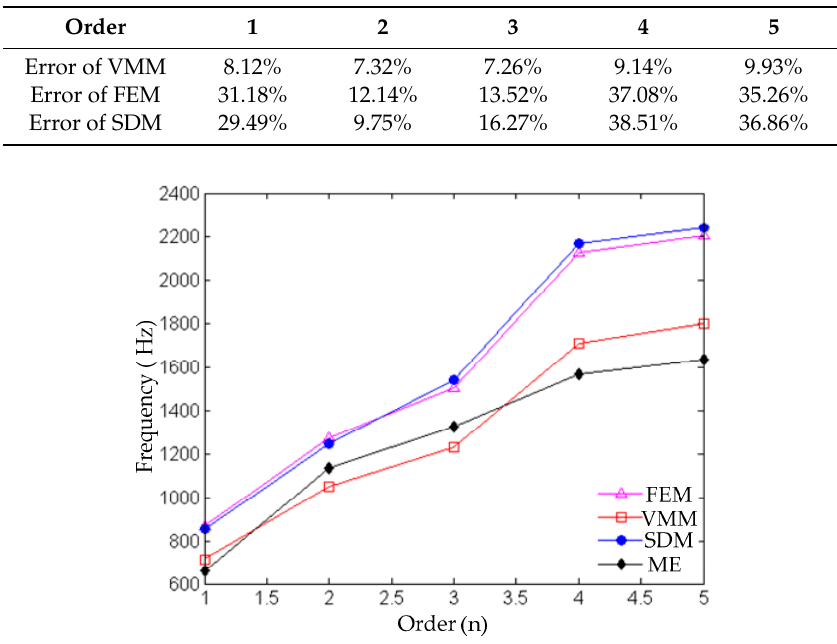
Figure 7. Comparison of the first five frequencies obtained by simulation and experiment.